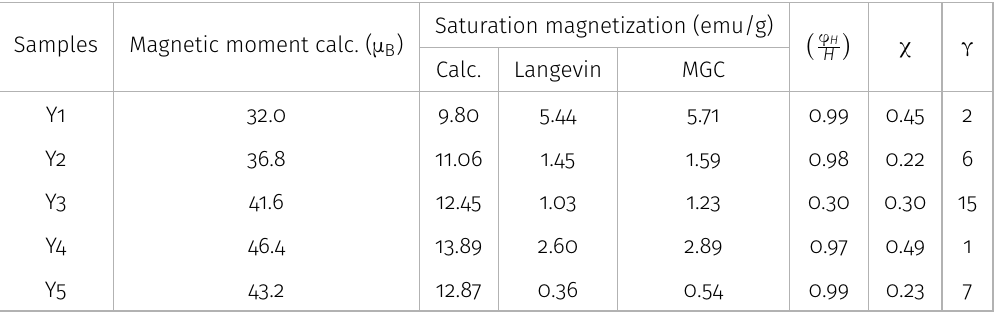
Table III. Results of magnetization data analysis for the Zn-doped magnetite ferrofluids. Saturation magnetization Samples Magnetic moment calc. ( μ B )